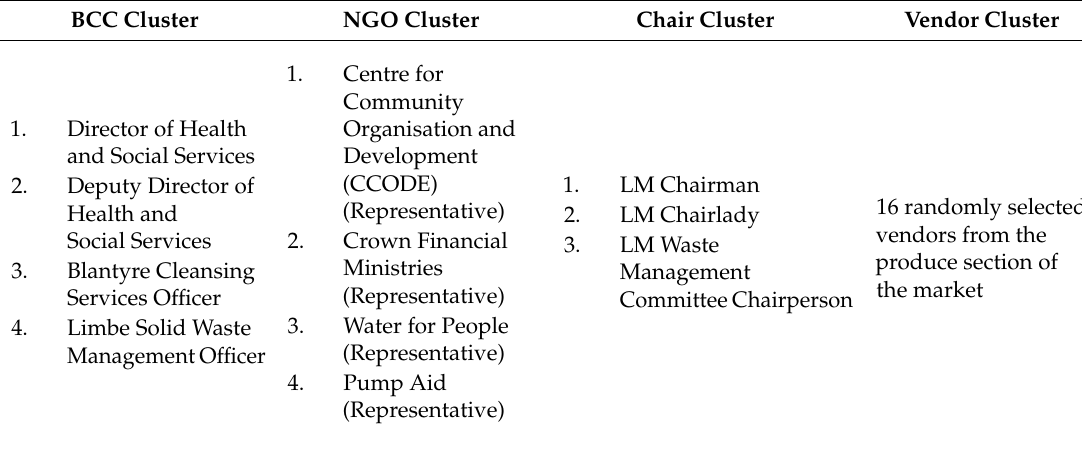
Table 3. Four stakeholder clusters